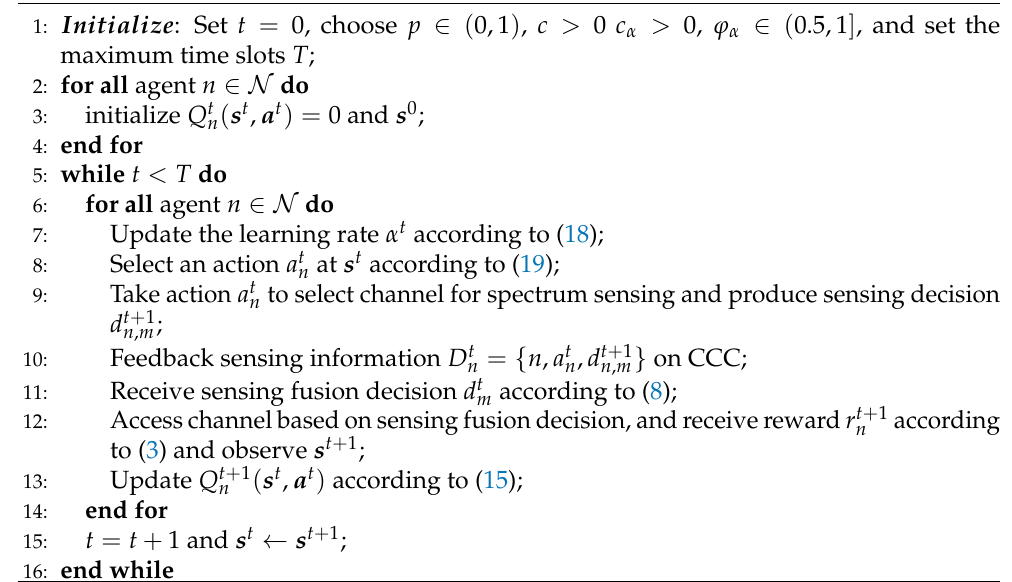
Algorithm 1 : IL-Q-UCB-H